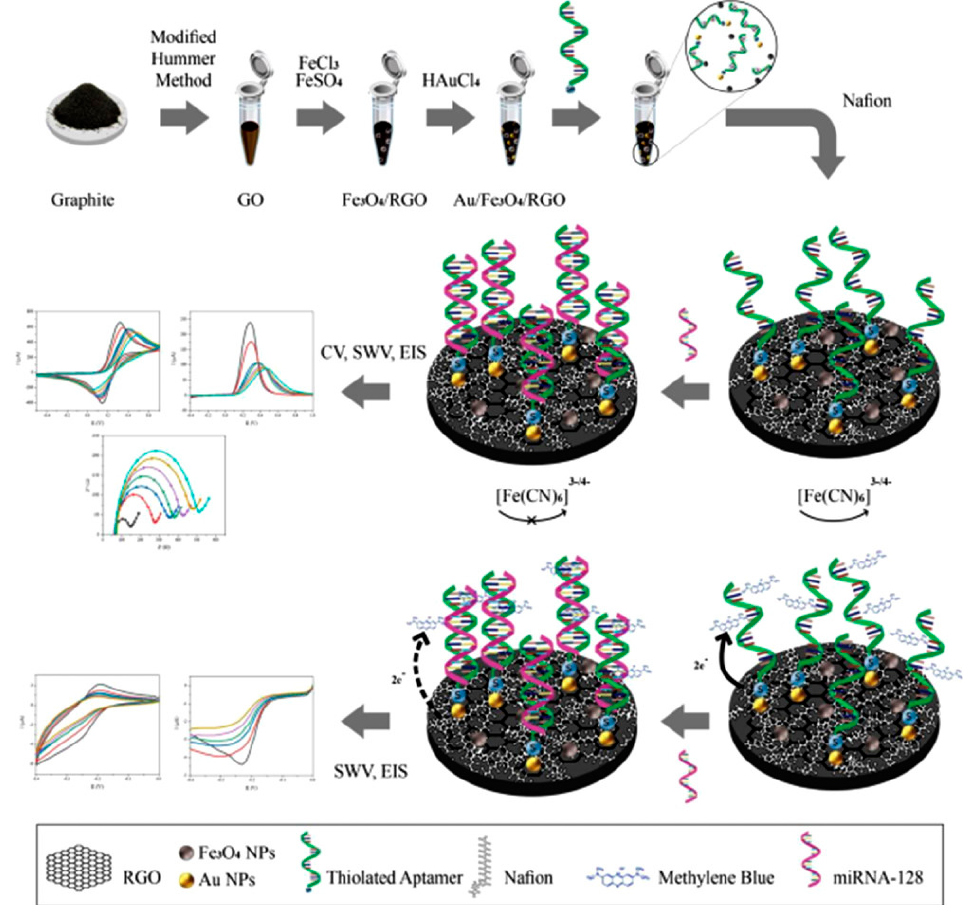
Figure 2. Schematic representation of Au NPs/Fe 3 O 4 /rGO nanocomposite preparation, immobilization of label-free as well as labeled aptamer on the surface of Au NPs/Fe 3 O 4 /rGO, and electrochemical analysis for determination of miRNA-128 concentration [23], reprinted with permission from WILEY.